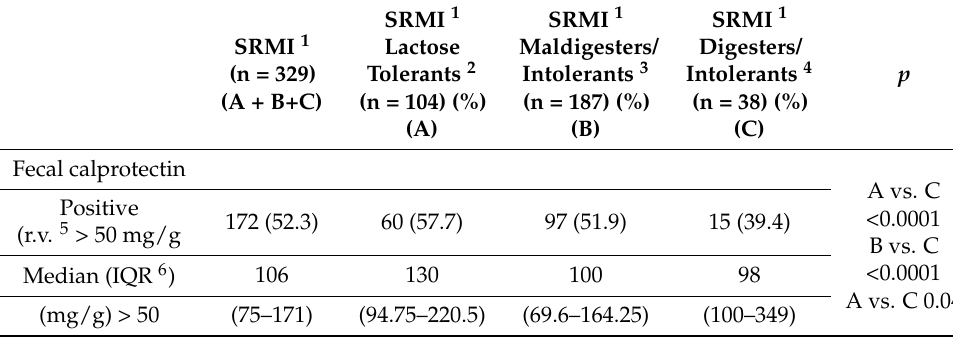
Table 2. Fecal calprotectin in patients with